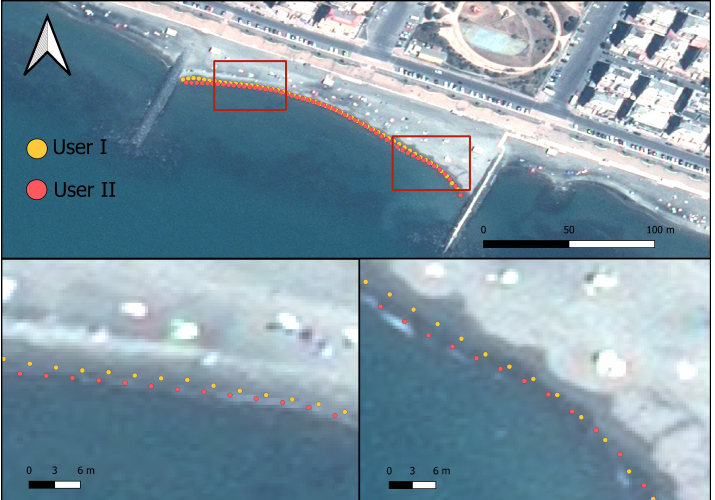
Figure 5. Example of manually digitized shorelines (yellow: User I; red: User II) in Ostia, plotted on the pan-sharpened Pleiades image. Background image: Pléiades-1A @ CNES (2020), distributed by Airbus DS, provided under COPERNICUS by the European Union and ES, all rights